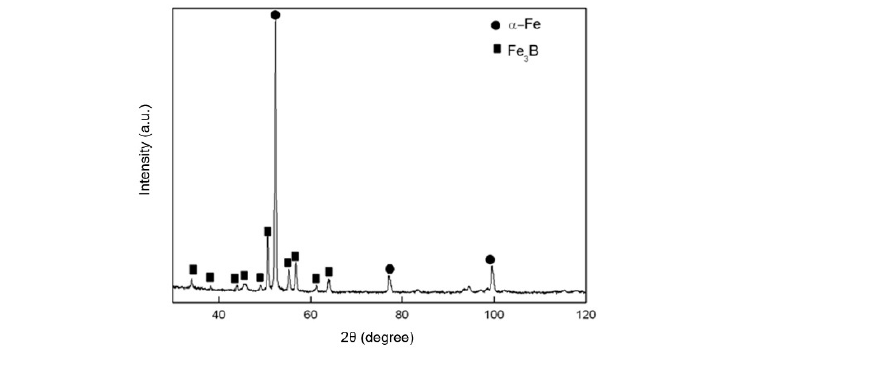
Figure 2. XRD profile for the crystallized Fe 85 B 15 alloy annealed at a rate 5 K min − 1 . The crystalline in the alloy was detected as α -Fe (PDF number: 06-0696) and tetragonal Fe 3 B (PDF number: 39-1315) by applying the MDI Jade 6.0 program.